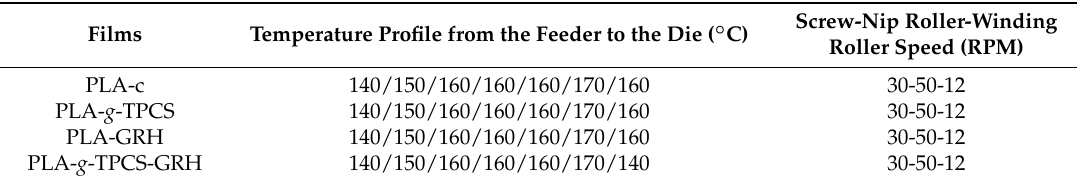
Table 2. Processing conditions of the cast